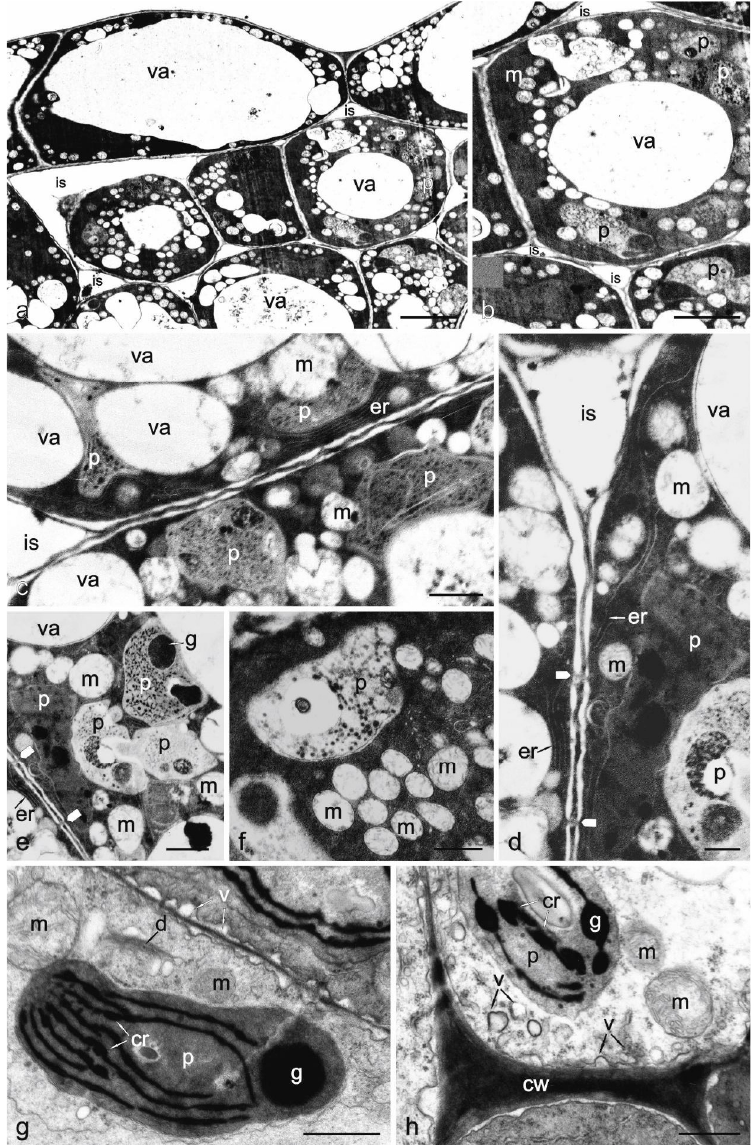
Figure 7. Ultrastructure of the floral nectary Dracocephalum moldavica (TEM). ( a ) Vacuolated epider- mal and parenchyma cells of nectary with electron-dense cytoplasm, numerous mitochondria with a transparent matrix, and intercellular spaces of different sizes. ( b ) Nectary parenchyma cells with dense cytoplasm, many plastids, mitochondria, and vacuoles; ( c ) Parts of two nectary parenchyma cells with pleomorphic plastids with small plastoglobuli, mitochondria, and vacuoles; ( d ) Plastids with plastoglobuli, mitochondria, vacuoles, smooth ER, and plasmodesmata (white arrowheads) in the wall of nectariferous cells; ( e ) Cluster of plastids with large plastoglobuli, some of them connected, mitochondria and plasmodesmata (white arrowheads); ( f ) Numerous mitochondria with distinct cristae and plastids in the dense cytoplasm; ( g ) Plastid with crystalloids and large plastoglobuli, mitochondria, dictyosome, and plasmalemma invaginations; ( h ) Part of the cell with a chromoplast with crystalloids and plas- toglobuli, mitochondria, many vesicles, and plasmalemma invaginations; va—vacuole; p—plastid; m—mitochondrion; cw—cell wall; d—dictyosome; v—vesicle; is—intercelluar space; cr—crystalloid; g—plastoglobule. Scale bars: 5 µ m ( a , b ), 1 µ m ( c – e ), 0.5 µ m ( f – h